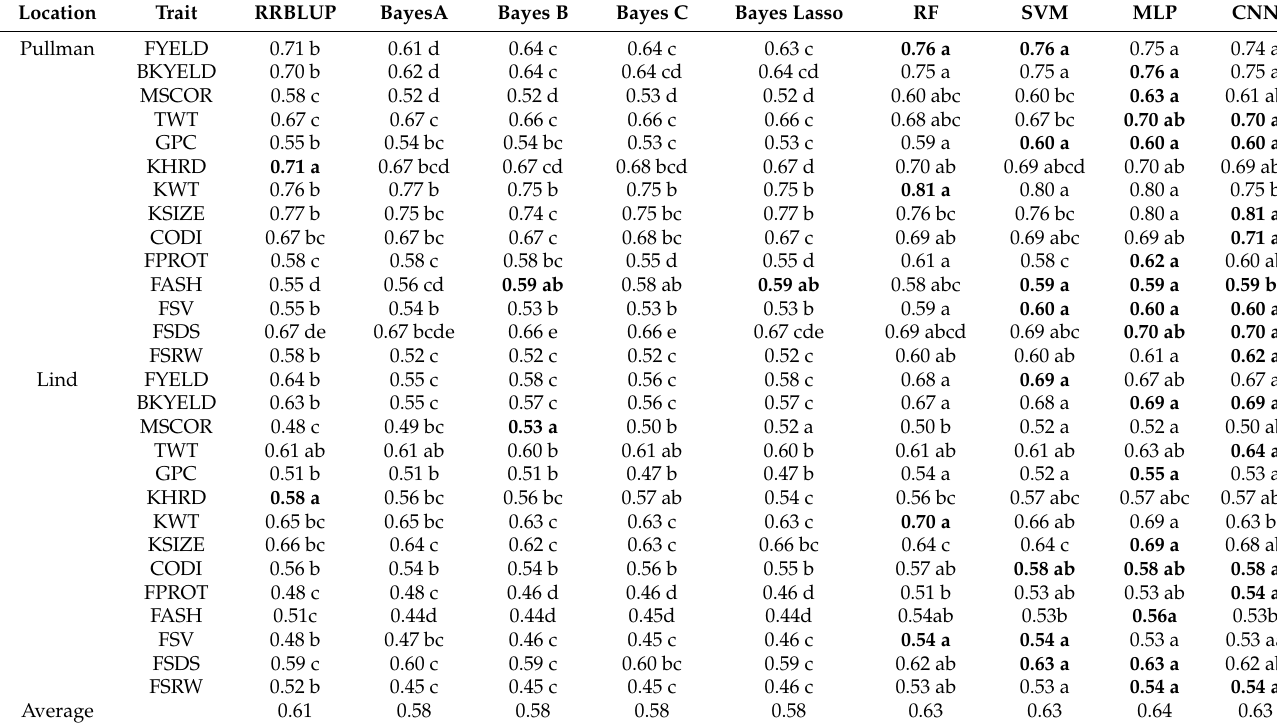
Table 3. Genomic selection cross-validation prediction accuracies for the fourteen end-use quality traits evaluated with nine different models at two locations in Washington. The highest accuracy for each trait is bolded under different model scenarios.